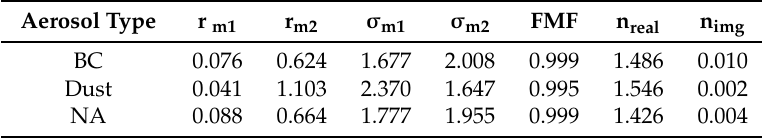
Figure 2. A priori covariance matrix derived from Carbon Tracker-Asia during 2010–2012 over East Asia. The colours represent the 1 - σ value between CO 2 mixing ratios at different levels, which is multiplied by a factor of 100. Levels are arranged from TOA to surface as 1–20. Table 3. Aerosol number-size distribution parameters and refractive index for each aerosol type in the YCAR algorithm. Number size distribution parameters are radius (r m1 , r m2 ) and variance ( σ m1 , σ m2 ) for fine and coarse and fine mode fraction (FMF), respectively. The real and imaginary parts of the refractive index for each aerosol type are n real and n img , respectively.